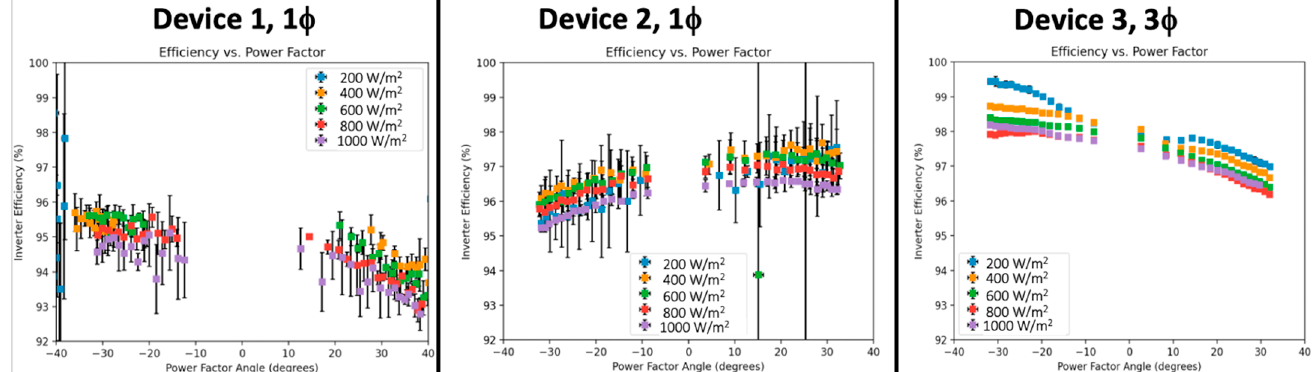
Figure 9. Efficiency measurements for different power factors and irradiance levels for Device 1, a single-phase inverter from manufacture A ( left ), Device 2, a single-phase inverter ( middle ) from Manufacturer B, and Device 3, a three-phase inverter ( right ) from Manufacturer B.